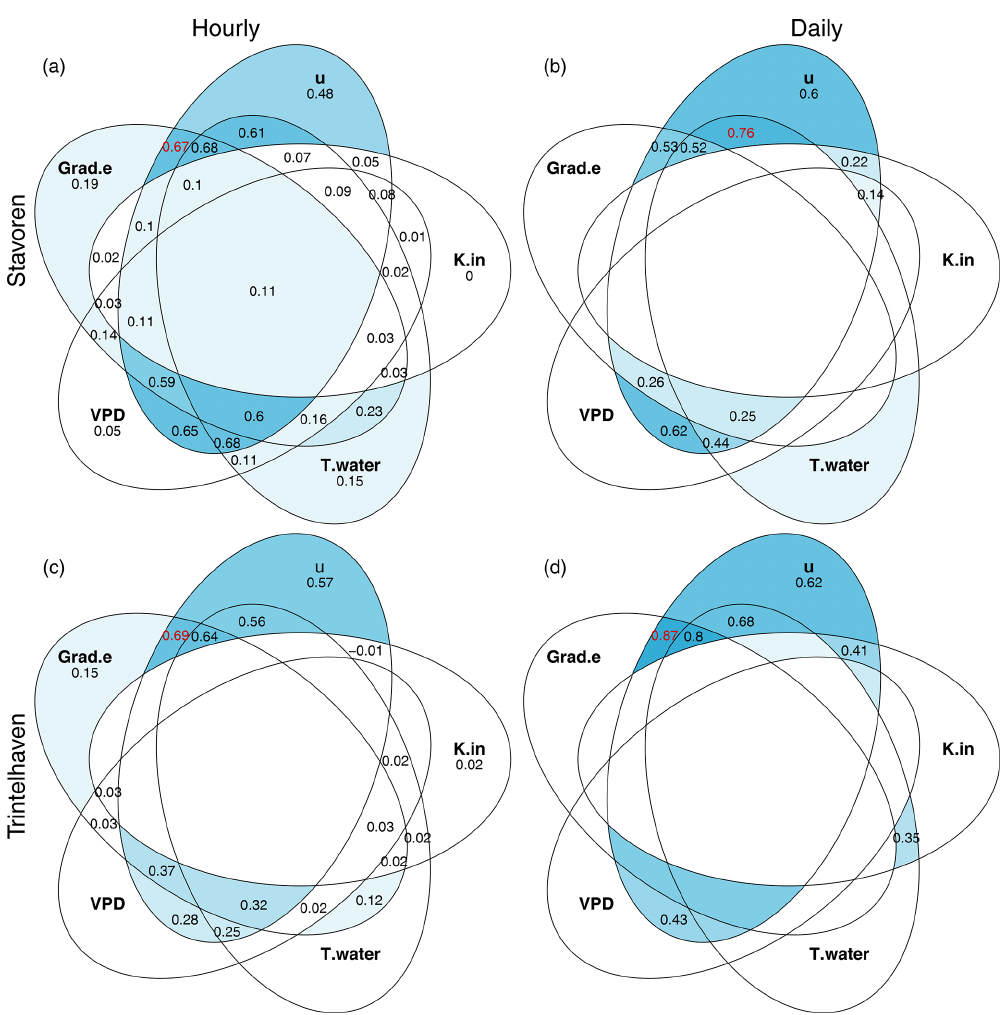
Figure D1. A systematic exploration of which variable or combination of variables (product) can best explain the dynamics of open water evaporation. The outer “leaves” of the Venn diagram represent the single variables, whereas the combinations of products of variables are represented towards the centre of the diagram. Within each leaf, the adjusted R 2 value is depicted. The higher this value, the bluer the colour of the leaf. The red number indicates the highest R 2 value, indicating the best combination found for a maximum of two variables, i.e. the best “simple” model. The R 2 values were removed if the model fit was found to be insignificant ( p < 0 . 05). The analysis is based on data from the summer of 2019 and is performed at an hourly timescale – Stavoren (a) and Trintelhaven (c) – and a daily timescale – Stavoren (b) and Trintelhaven (d)